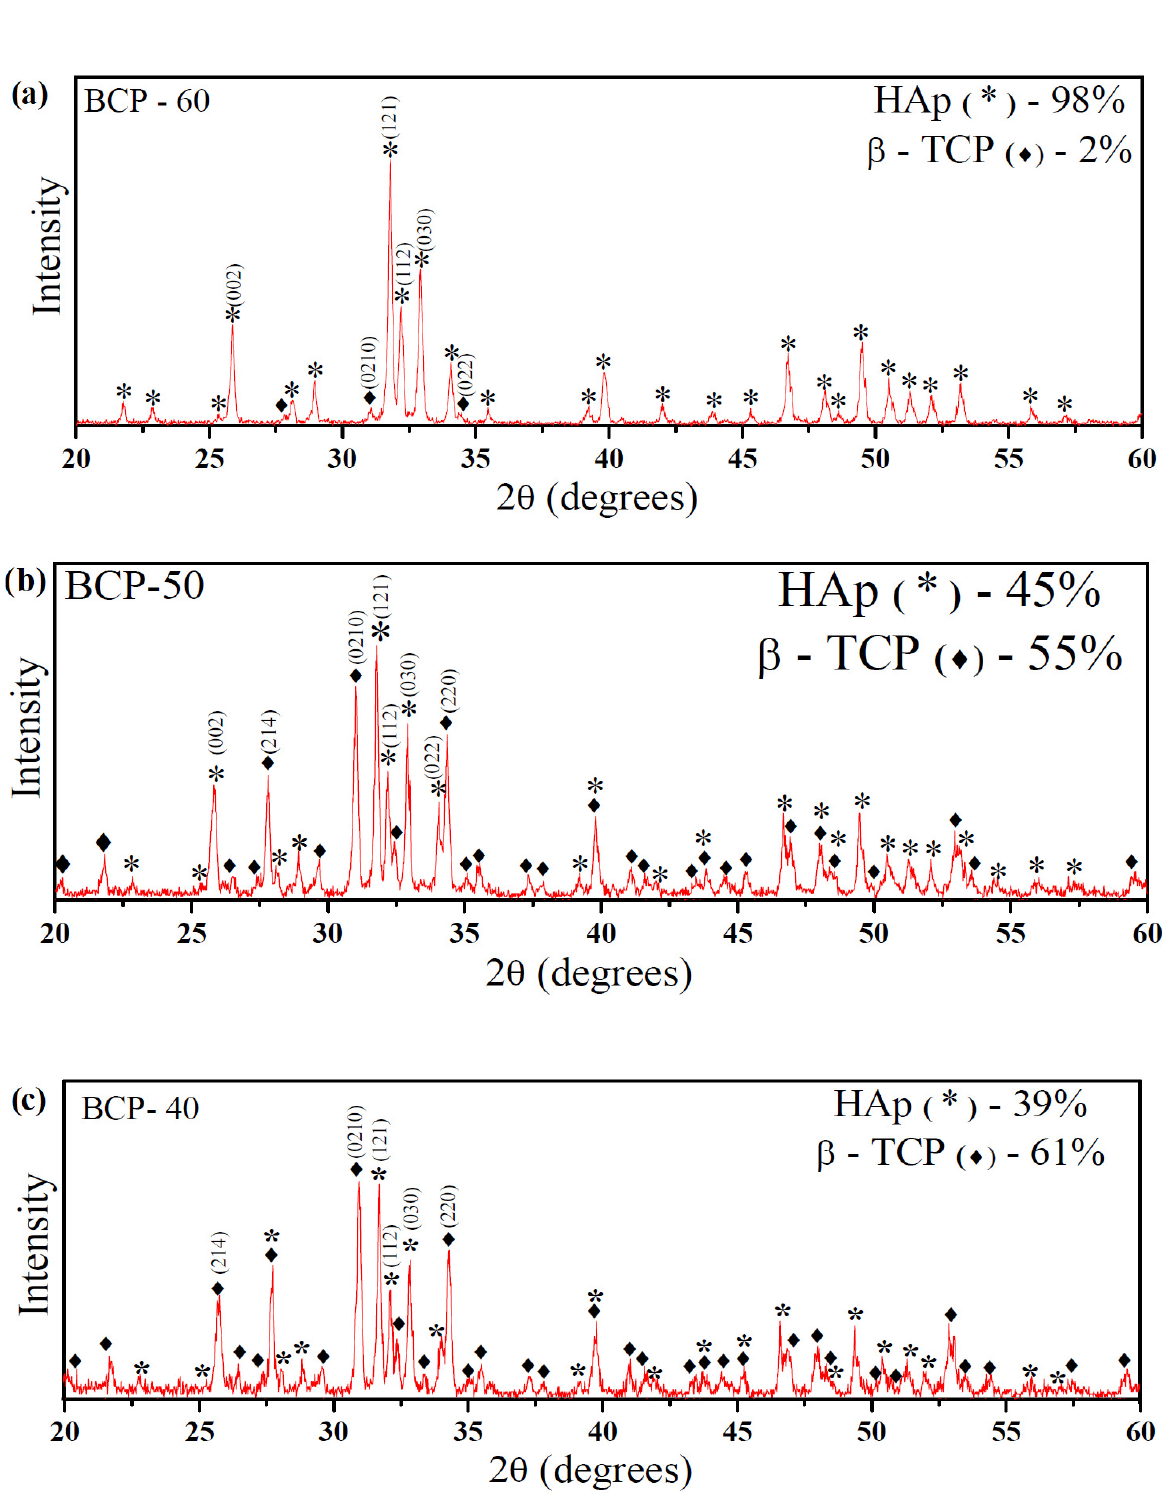
Figure 2. X-ray diffractograms of the synthesized samples BCP-60 ( a ), BCP-50 ( b ), and BCP-40 ( c ), varying the AC/EG ratio in the proportions of 60/40, 50/50, and 40/60, respectively. The average crystallite sizes ranged from 60.6 to 63.1 nm, evidencing the nanometric character of the particles, in agreement with the literature [16–19]. In addition, all samples showed high crystallinity values, ranging from 82.3 to 94.8%, where these increased as the proportion of citric acid in ethylene glycol